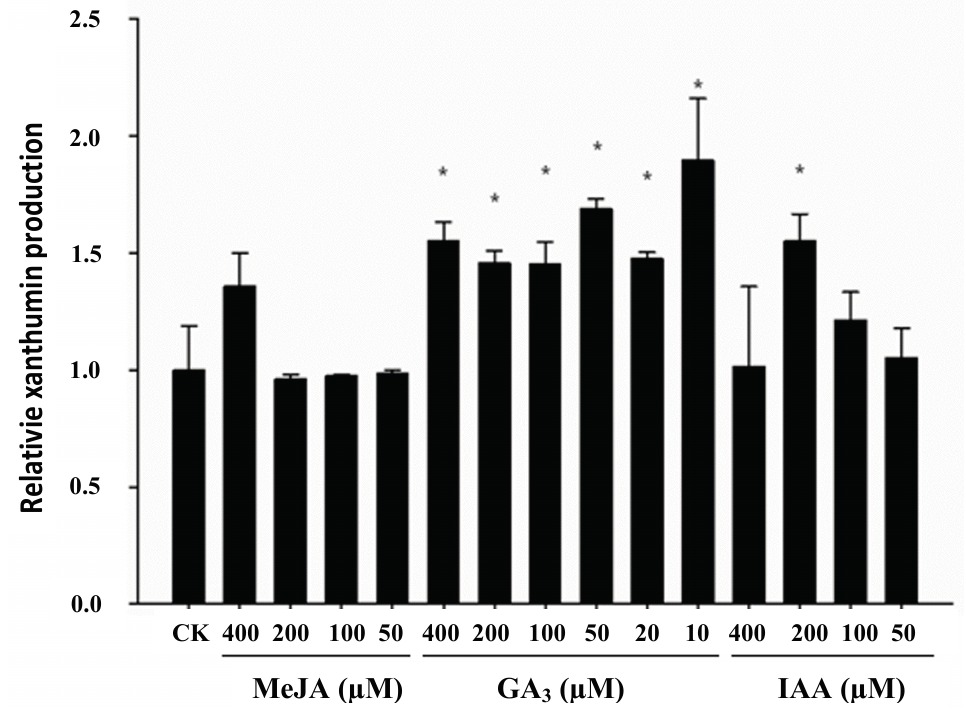
Figure 1. The effect of phytohormonal treatments on xanthumin accumulation in X. strumarium L . young leaves. We set the average HPLC area of xanthumin of the control plants as 1, and that of the hormones-treated plants was normalized thereto. Bars are standard errors. Asterisks indicate significant differences. * p <